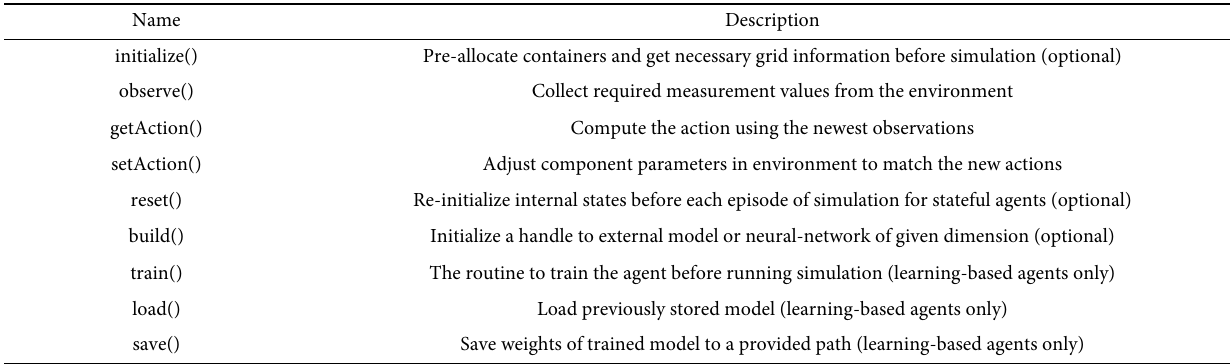
Table 1 Standard function names for agent